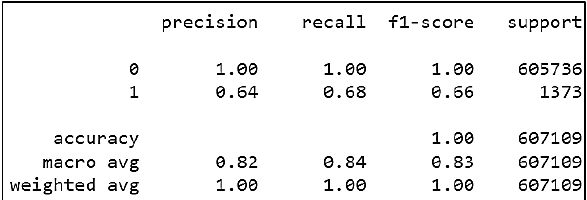
Figure 14: Mineral map predicted using Random Forest (Generated and reclassed in GIS Software).